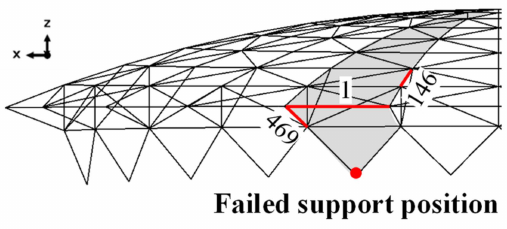
Figure 14. Failed supports and monitored critical member